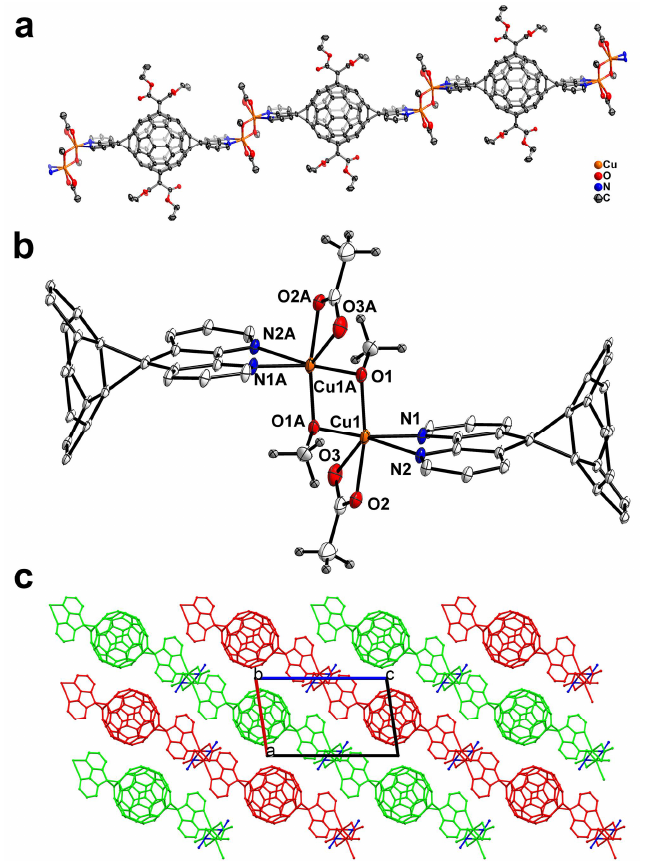
Figure 5. Perspective view of ( a ) 1D dinuclear Cu(II)-linked stair-like chain structure of 4 , front and back malonate addends and all hydrogen atoms have been omitted for clarity; ( b ) the coordination environment of Cu ions in 4 ; ( c ) the parallel packing motif of 4 viewed along the b- axis; hydrogen atoms and malonate addends have been omitted for